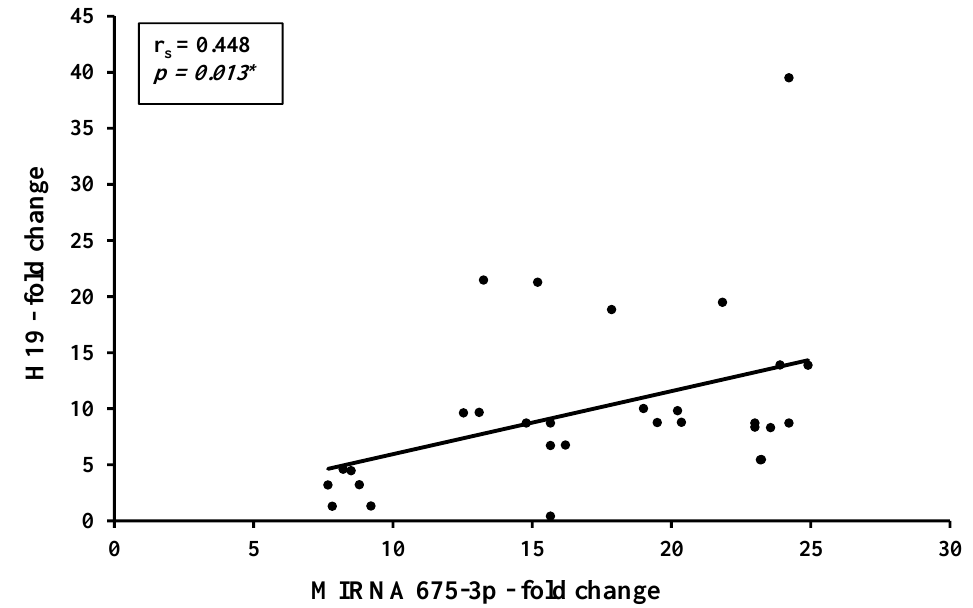
Figure 9. Correlation between circulating H19 with miR-675-3p in presurgery BC ( n = 30). *: Statistically significant at p ≤ 0.05.